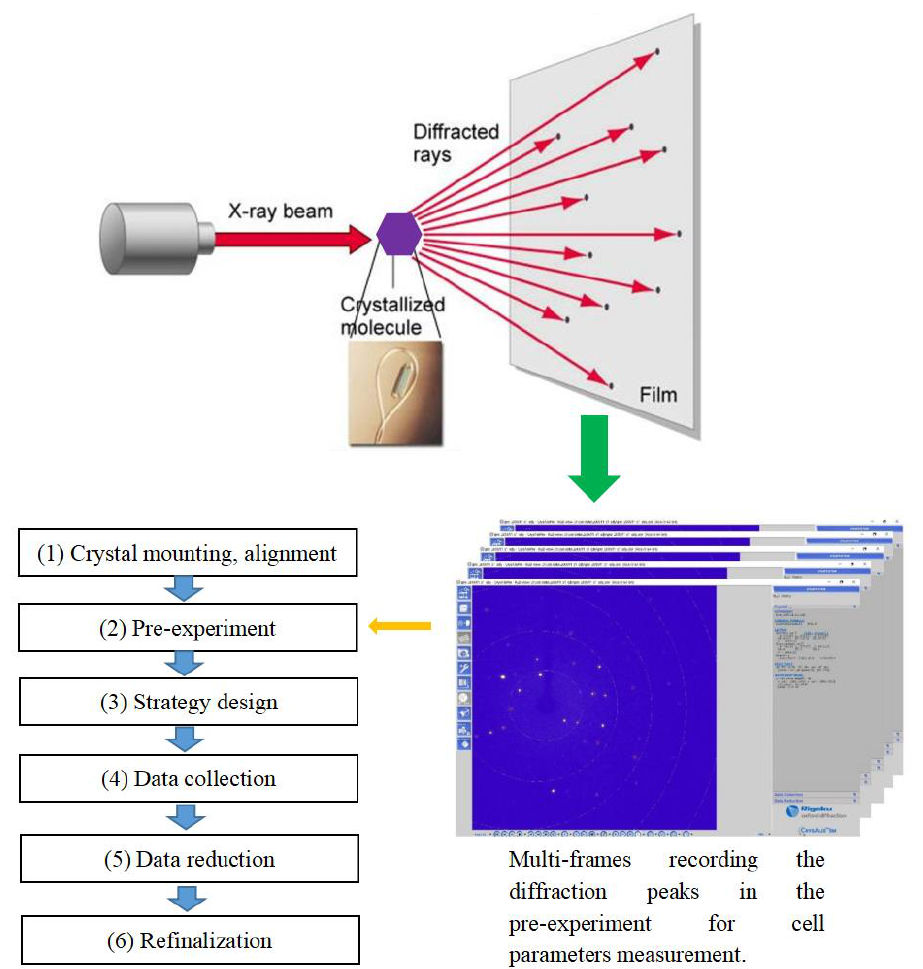
Figure 2. Schematic illustration of the crystal data collection process including 6 steps on the spectrometer device. About 20 frames of the diffraction peaks are recorded in the pre-experiment step, which strictly affects the strategy design of the complete data collection. The cell parameters, especially the lattice volumes of the sample, are crucial to determine the strategy